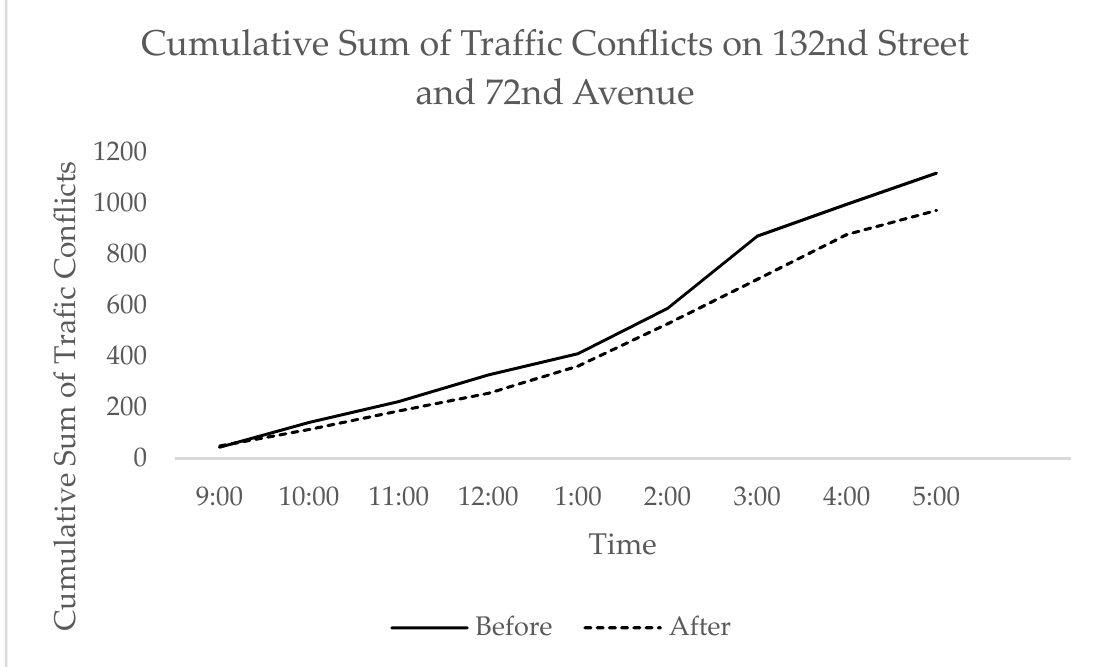
Before After Figure 9. The effect of market penetration rate on conflict rate. Table 3. Variation of conflict rate per hour on 72nd Avenue (EB and WB approaches). Entire Intersection EB and WB Approaches Average Hourly Conflict